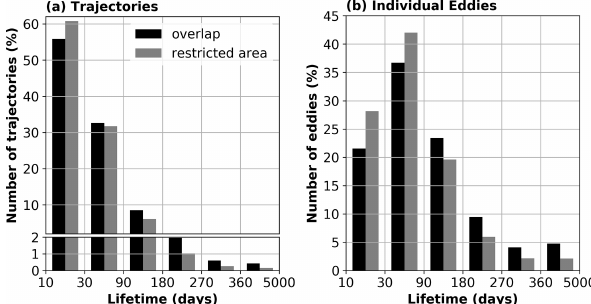
Figure 2. Distribution of the number of (a) trajectories and (b) indi- vidual eddies by lifetime for the restricted area (gray) and the over- lap (black) tracking methods built from the same detection dataset. Percentages are relative to the number of